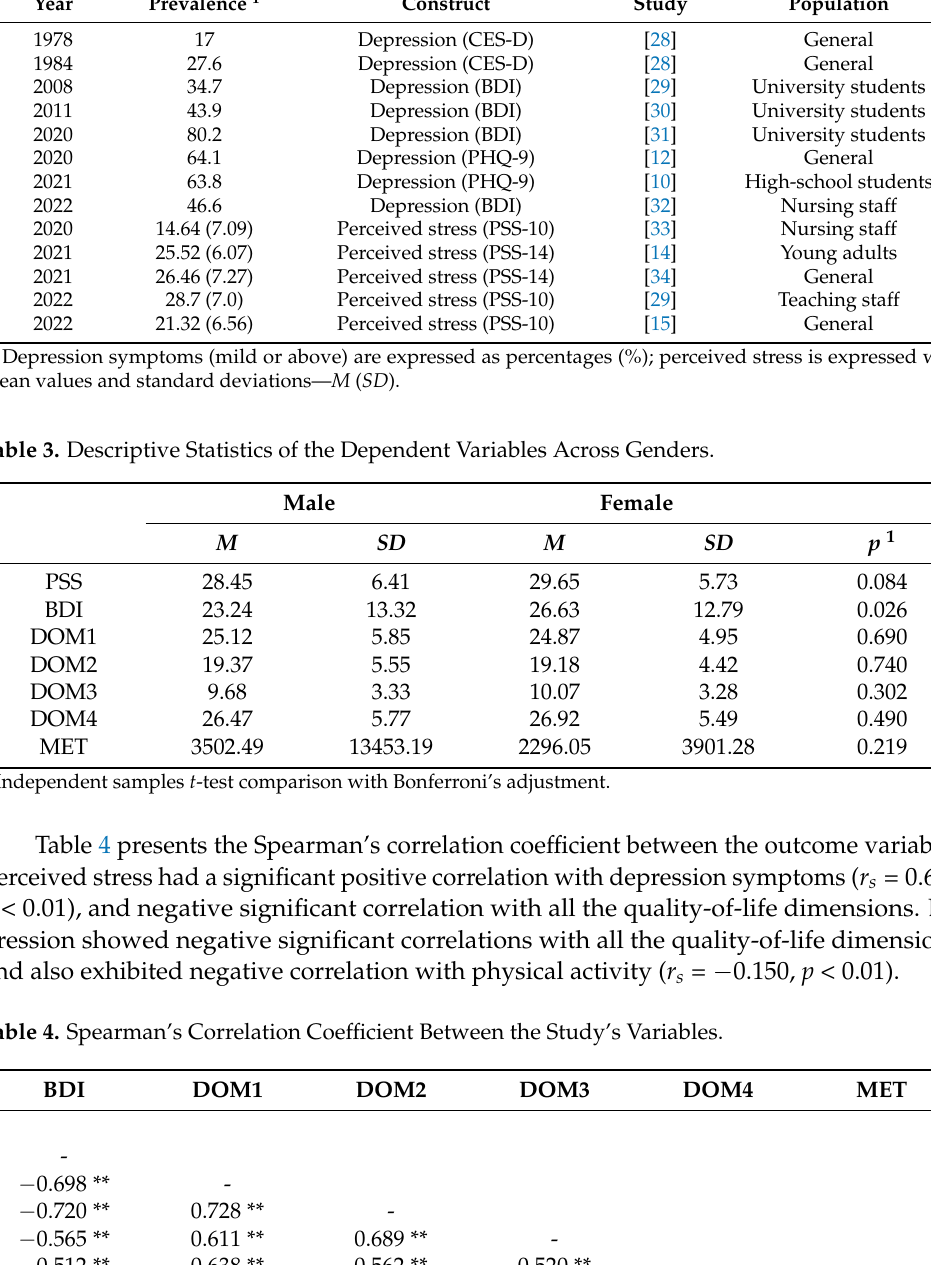
Table 2. Prevalence of Depression Symptoms and Perceived Stress in Greece.